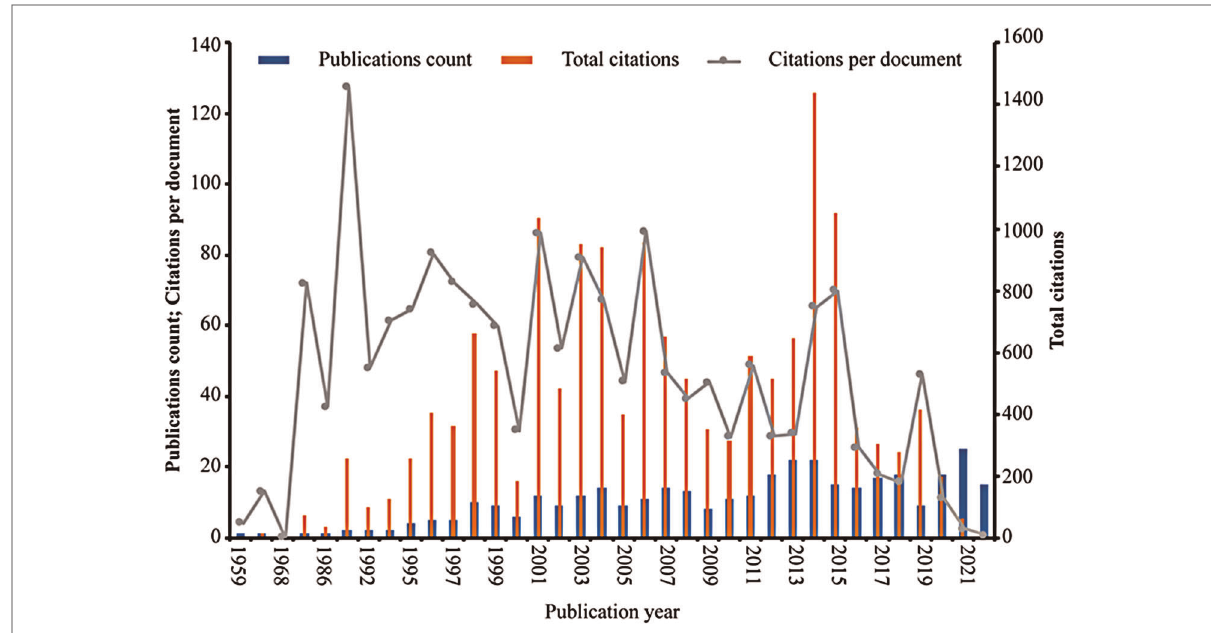
FIGURE 2 Number of annual publications, total citations, and average citations per document of the research. The blue bars represent the annual publication count, the orange bars represent the total number of annual citations, and the grey line represents the annual average number of citations per document.